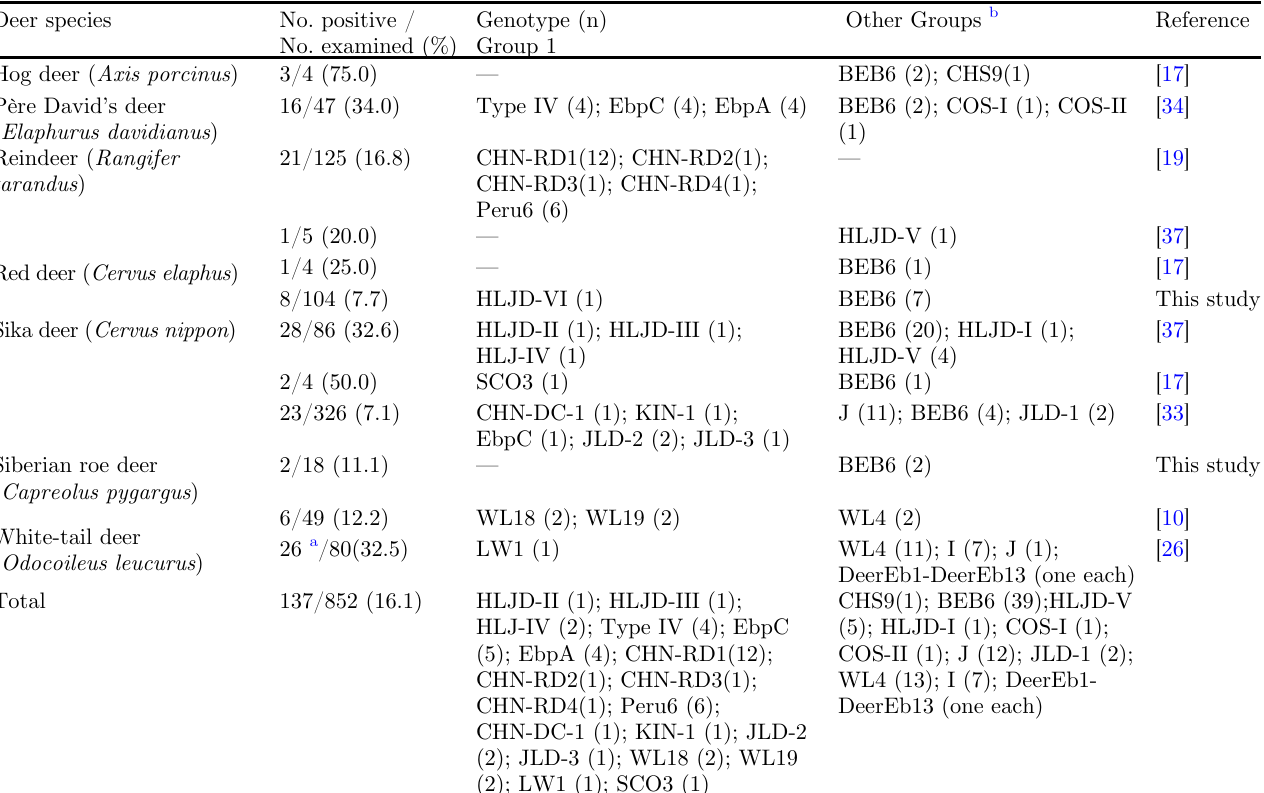
Table 3. Prevalence and genotype distribution of Enterocytozoonbieneusi in natural infection of deer species